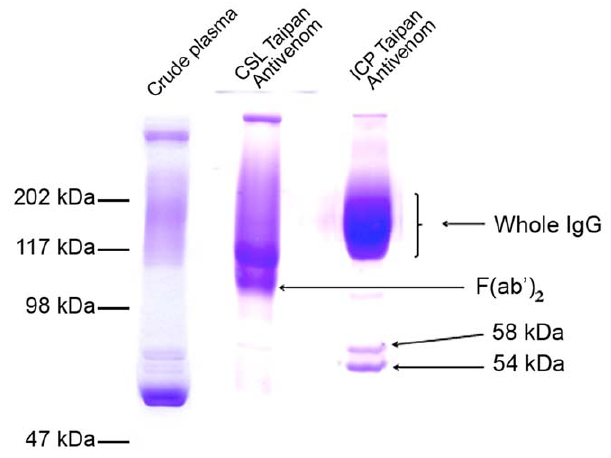
Figure 2. Electrophoretic analysis of antivenoms. Non-reduced samples were loaded in a 7.5% polyacrylamide gel in the presence of SDS. After separation, proteins were stained with Coomassie Brilliant Blue R-250. Migration of molecular mass markers is depicted to the left.